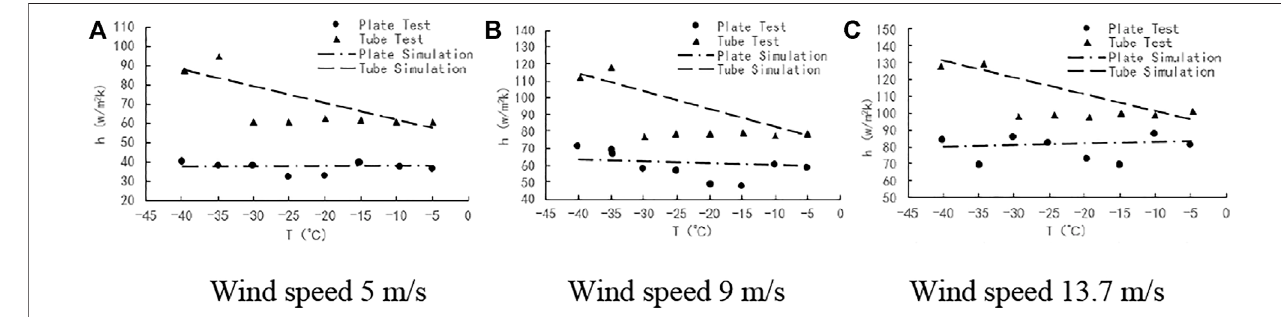
FIGURE 6 | Comparison between numerical simulation and experimental results of components.